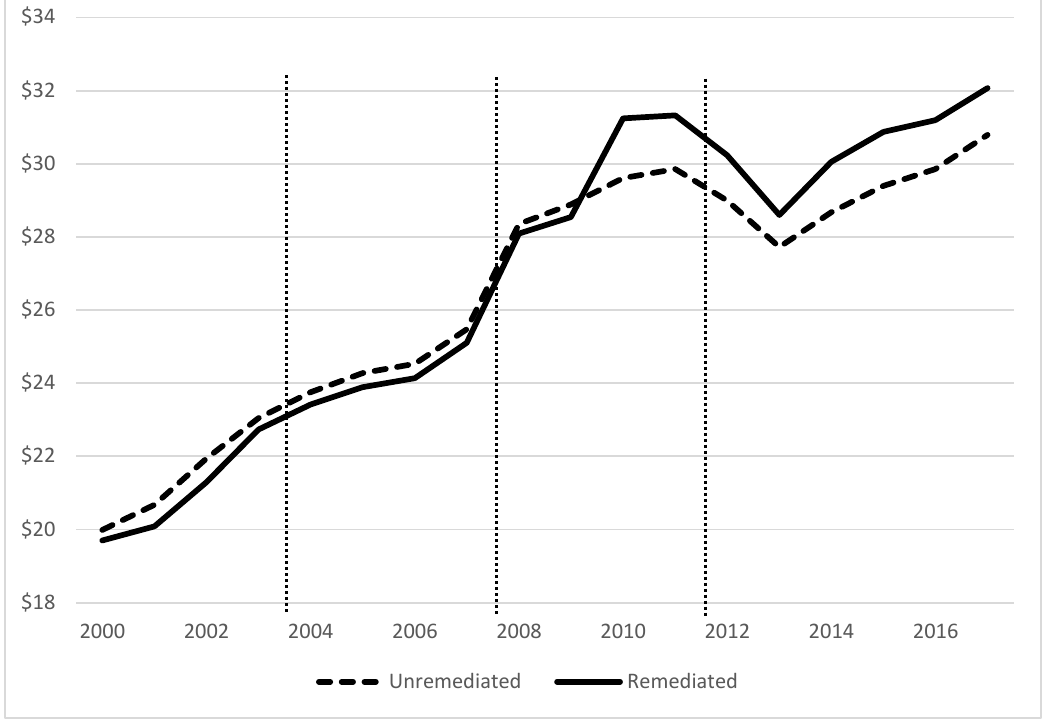
Figure 1. Average assessed value per square foot, separated by modeled time periods.